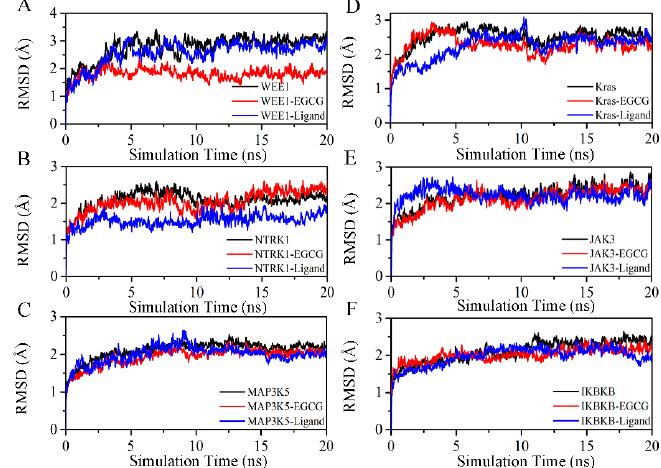
Figure 6. The backbone C α -RMSD values during the 20 ns MD simulation. The black, red and blue lines show the backbone C α -RMSD values of target proteins, target–EGCG complexes and target–ligand complexes, respectively. ( A ) The backbone C α -RMSD values of WEE1. ( B ) The backbone C α -RMSD values of NTRK1. ( C ) The backbone C α -RMSD values of MAP3K5. ( D ) The backbone C α -RMSD values of KRas. ( E ) The backbone C α -RMSD values of JAK3. ( F ) The backbone C α -RMSD values of IKBKB.